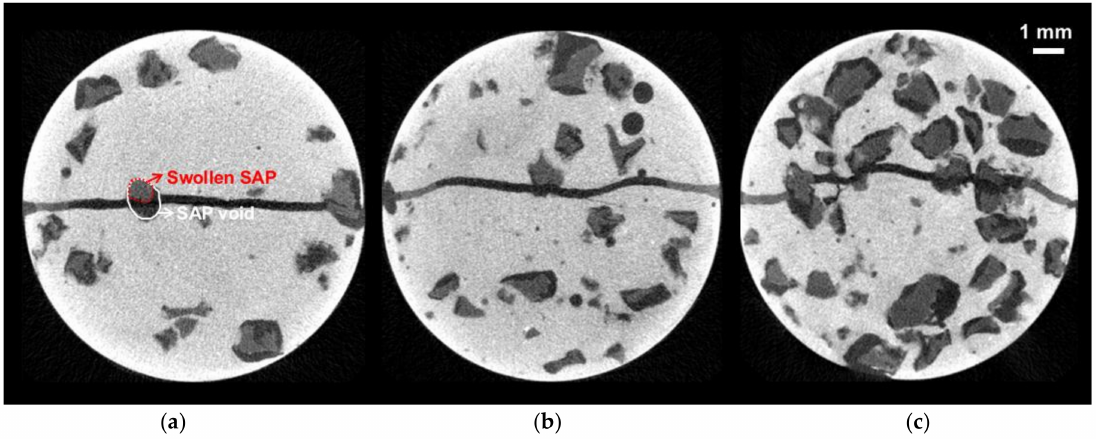
Figure 8. Gray-level X-ray micro CT image of ( a ) S-0.5, ( b ) S-1.0 and ( c ) S-1.5 specimen, taken after cracking.